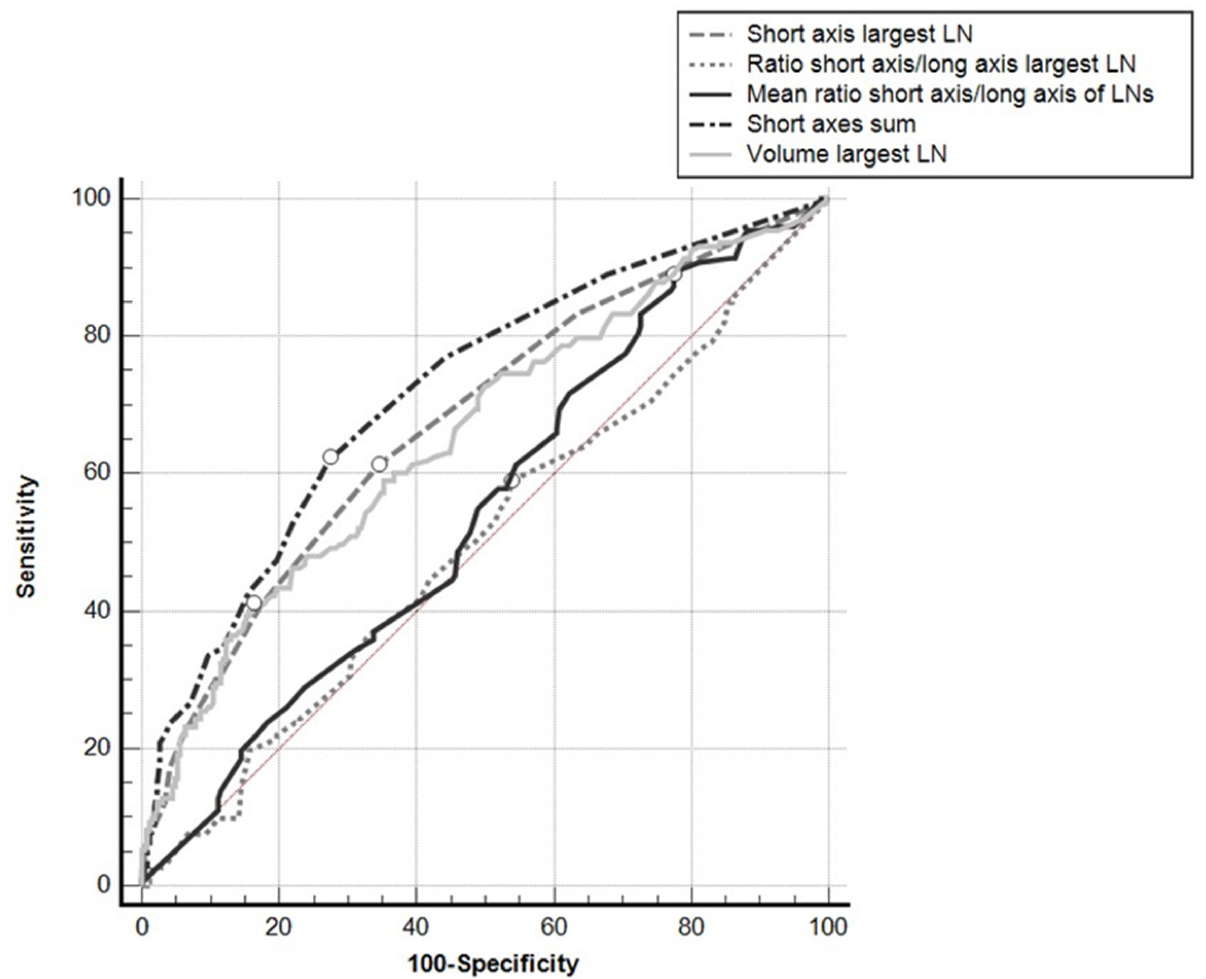
Figure 3. ROC curves for the different parameters used, taking positive/negative results for the nodal groups at histopathology for reference. White dots: Youden’s indexes.